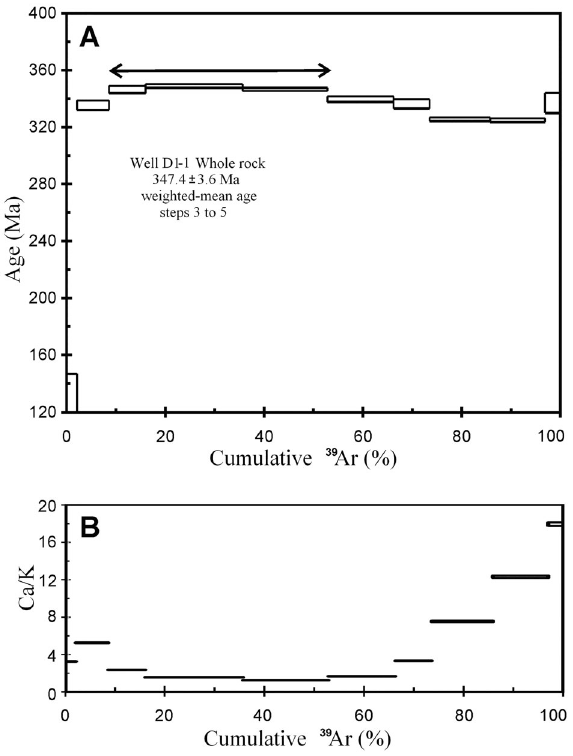
Fig. 4. A , gas release spectrum for whole-rock sample D1-1 (Leeds run 2483). Steps 3–5 yield a ca 347  3.6 Ma weighted- mean age. B , Ca/K vs released 39 Ar diagram showing a concave